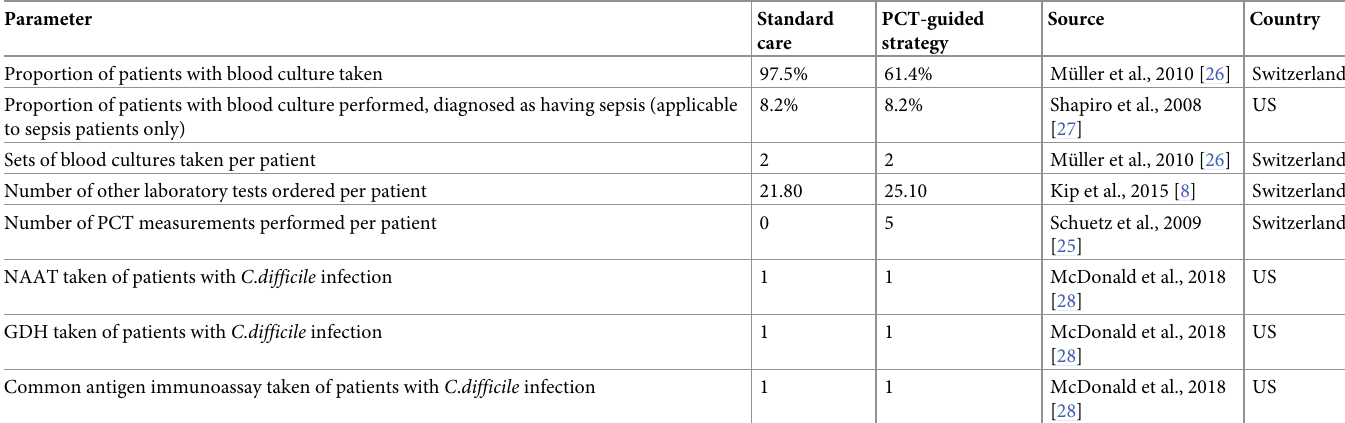
Table 2. Resource use.